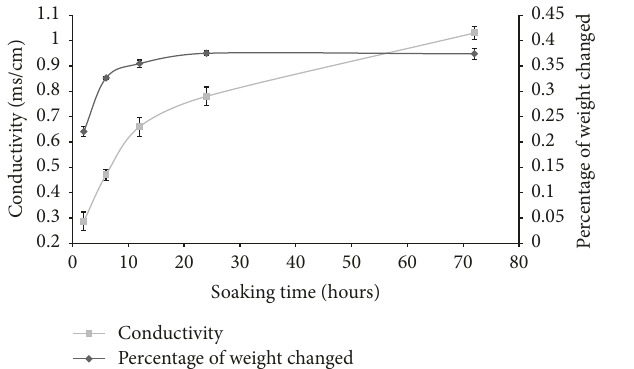
Figure 5: Percentage of weight changed on soaking and conductiv- ity of soaking water.